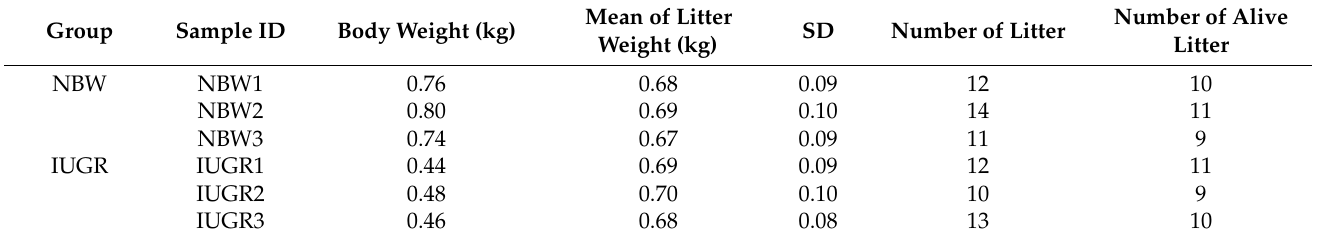
Table 1. Statistical Analysis of piglet weight in two groups.